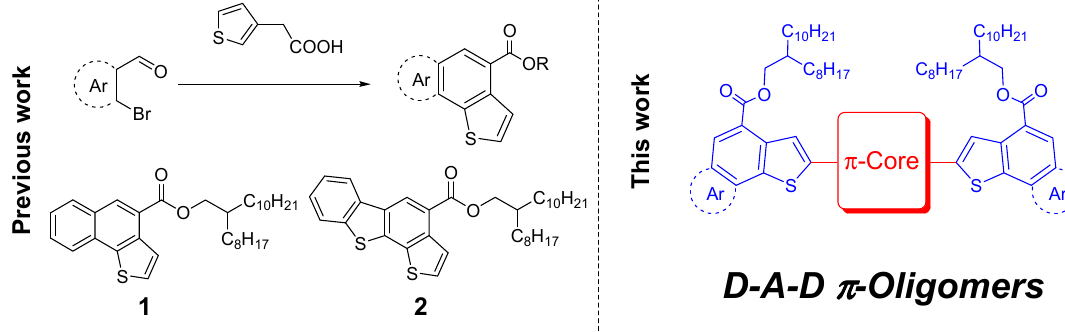
Figure 1. Left: reaction scheme for direct arylation (DHA)-cross aldol condensation between o -bromoaldehydes and 3-thiopheneacetic acid for the synthesis of annulated scaffolds 1 and 2 . Right: general depiction of novel oligomers synthesized and discussed in this work.